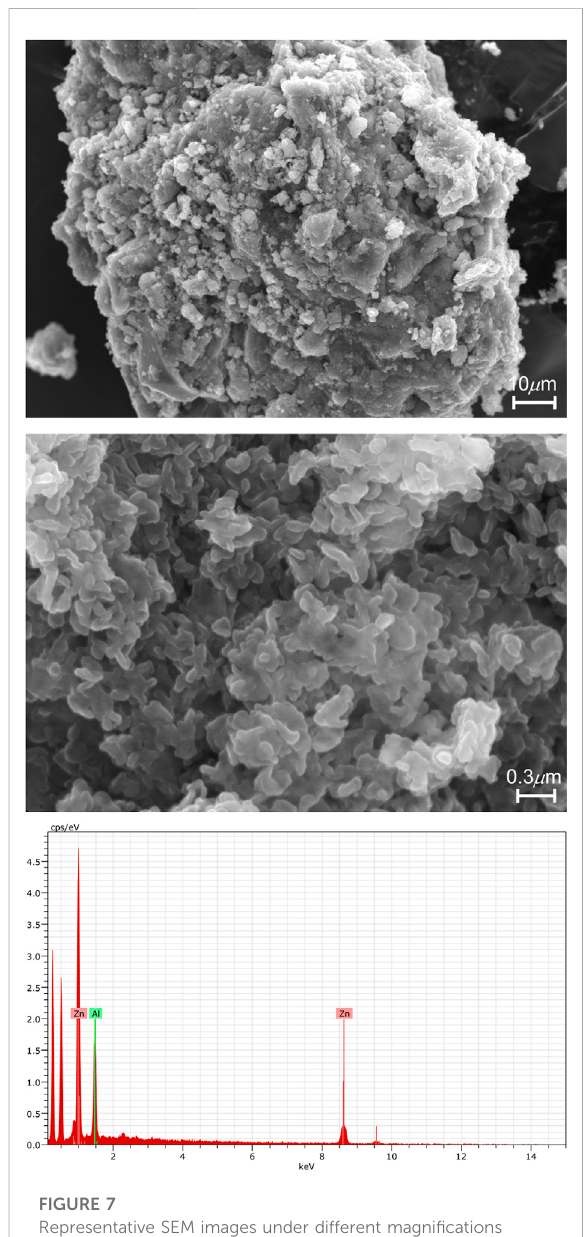
FIGURE 7 Representative SEM images under different magni fi cations and EDS spectrum of